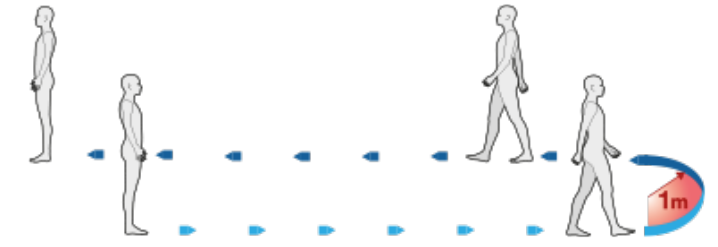
Figure 2. 10 m Walk